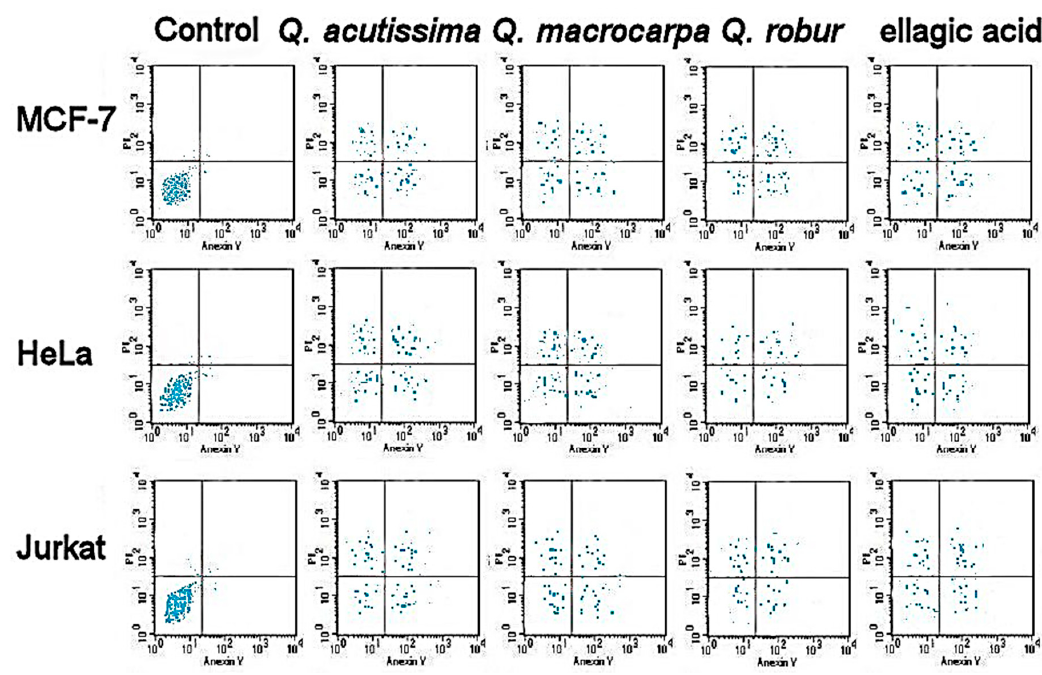
Figure 2. Apoptotic cell population (IC 30 ) using flow cytometry.